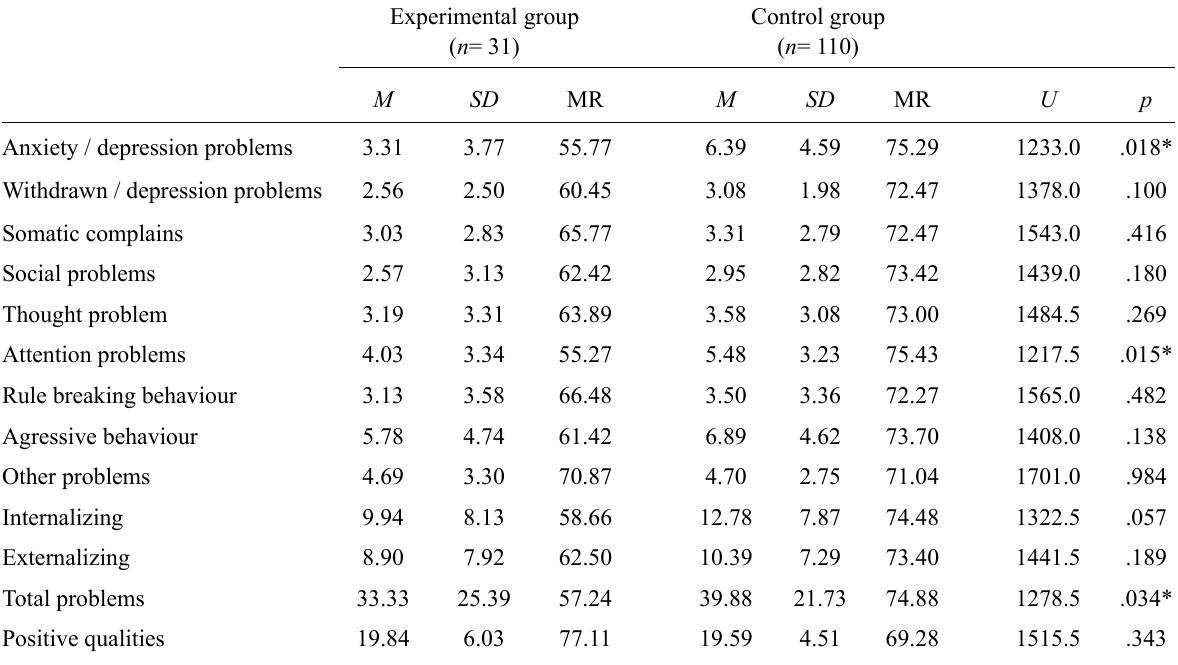
Experimental group ( n = 31)